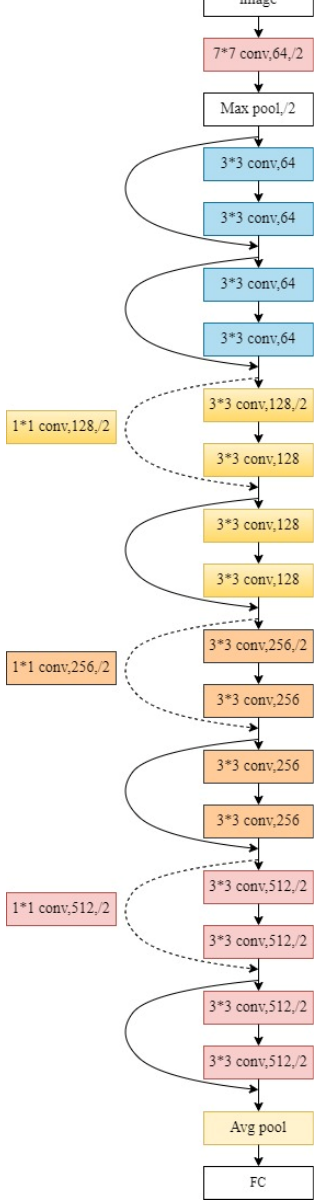
Figure 14. ResNet18 model.